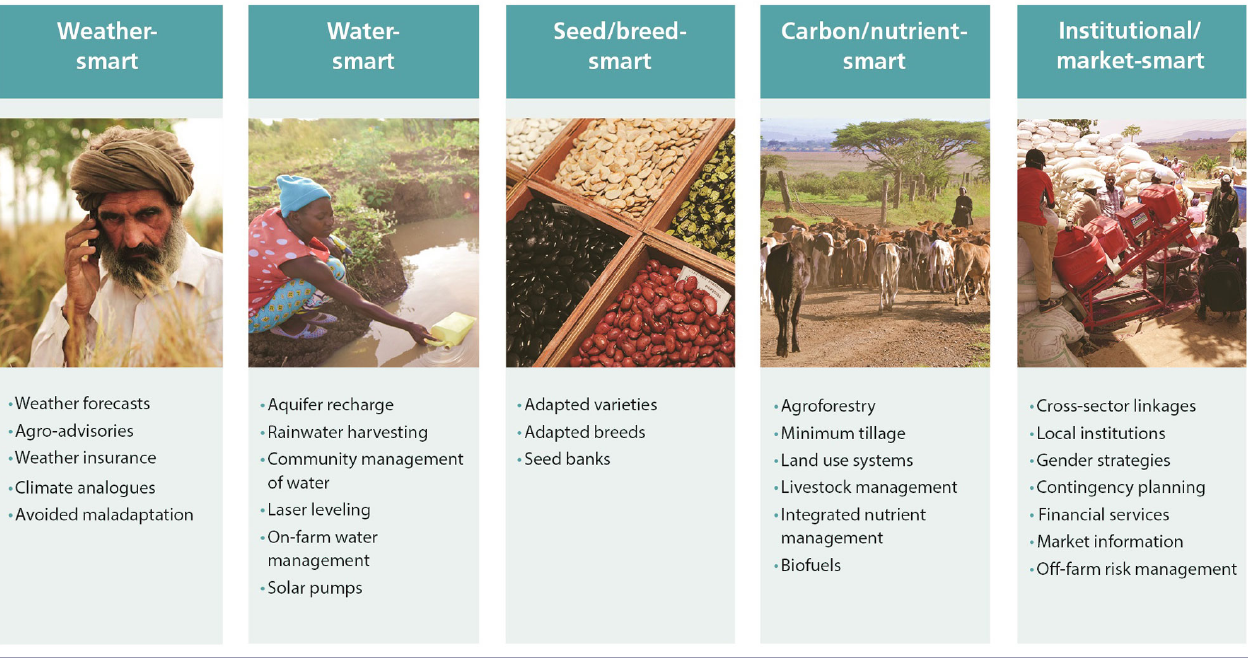
Fig. 3. Types of climate-smart options that may be tested as part of context specific portfolios in the CSV